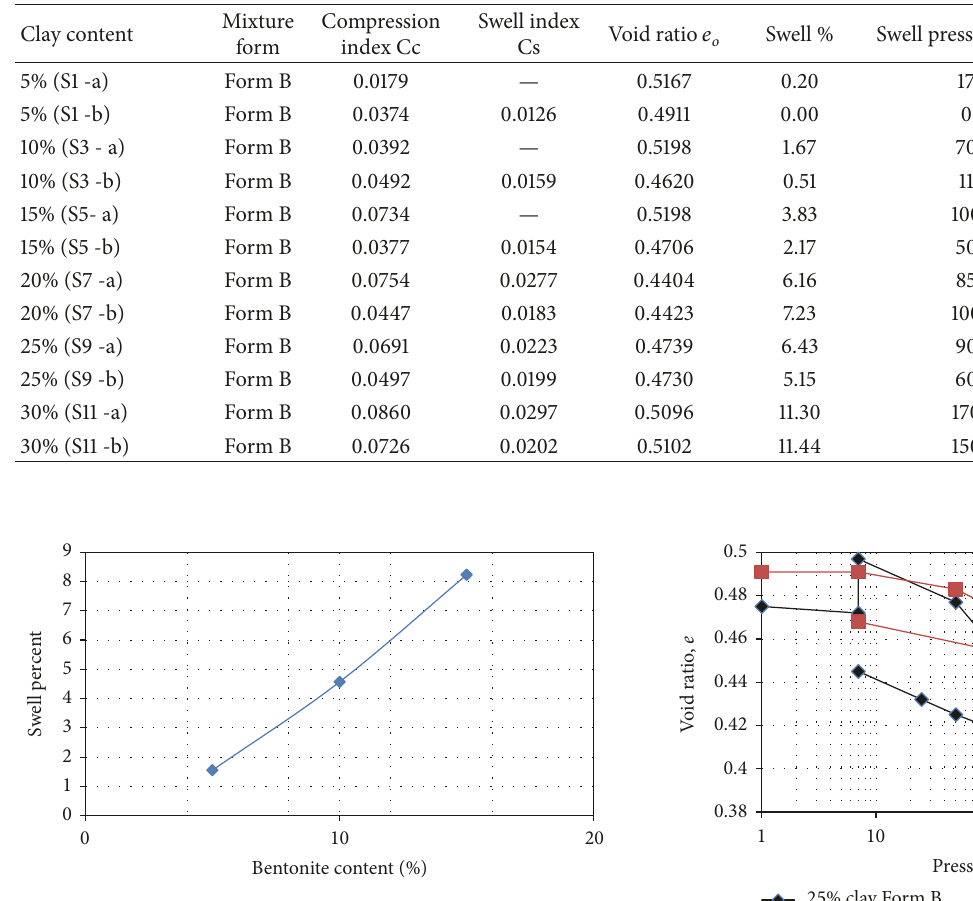
Figure 6: Swelling percent for different bentonite contents in the mixture.